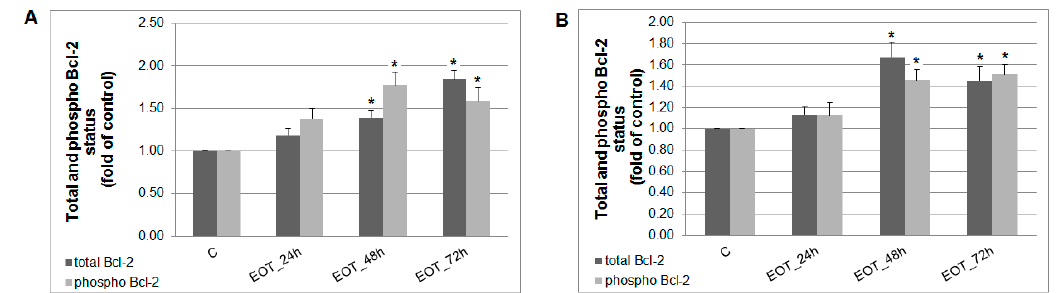
Figure 11. Distribution and activity of anti-apoptotic mitochondria-associated protein Bcl-2 after EOT treatment (0.13 or 0.12 µg/mL) in MCF-7 ( A ) and MDA-MB-231 ( B ) cells analyzed by flow cytometry. Results are expressed as the mean ± SD of three independent experiments and significant differences are given as * p < 0.05 versus untreated control.